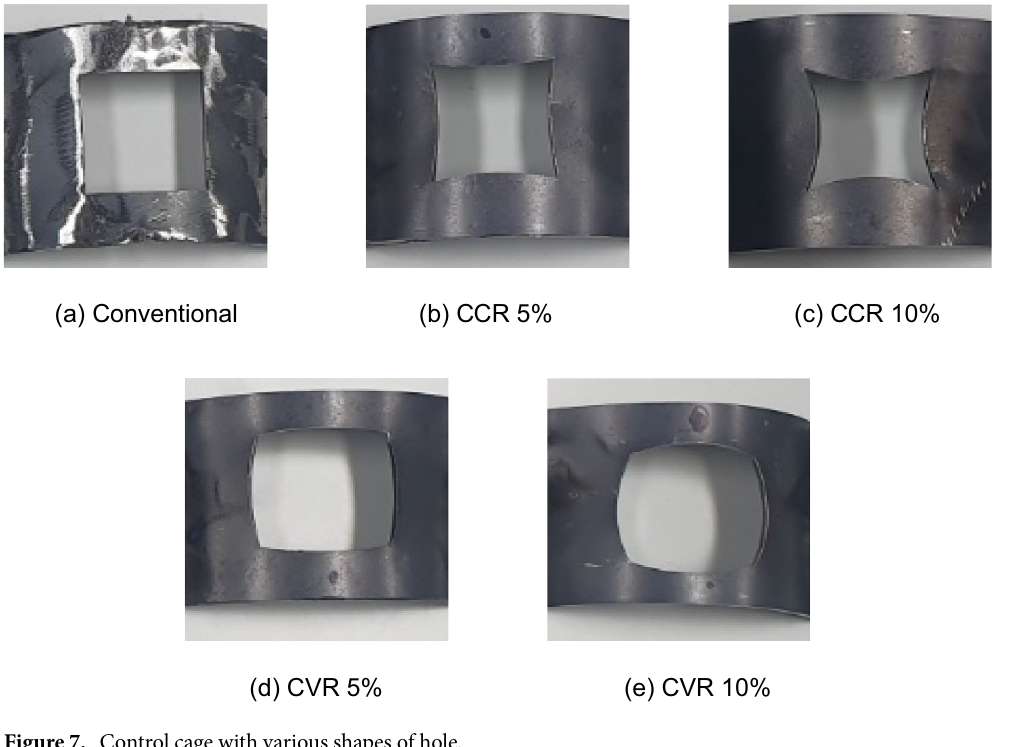
Figure 7. Control cage with various shapes of